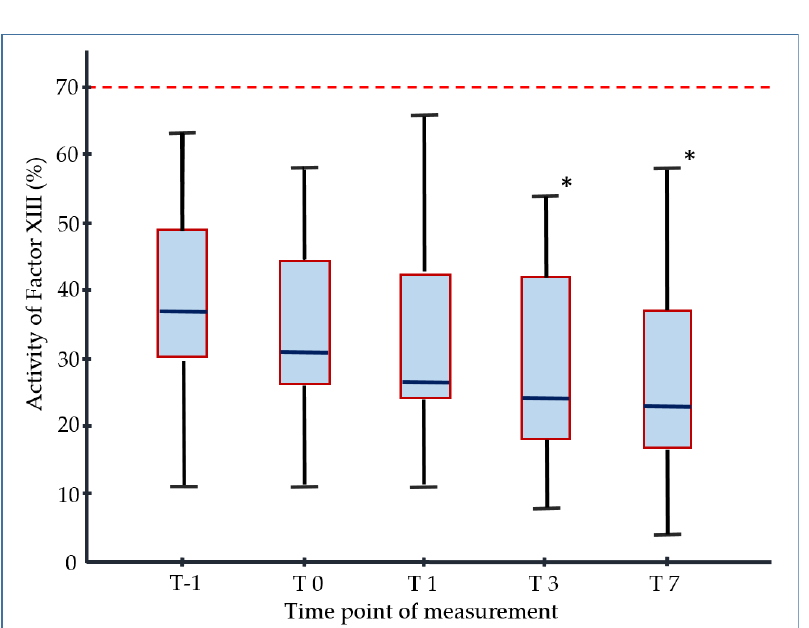
Figure 1. Activity of F XIII before (T-1) and after the initiation of vvECMO therapy over an observational period of seven days: 6 h (T0), 1 day (T1), 3 days (T2) and 7 days (T7); * indicates significant decrease in F XIII activity compared to T0; dotted line represents threshold to the normal reference range of F XIII.